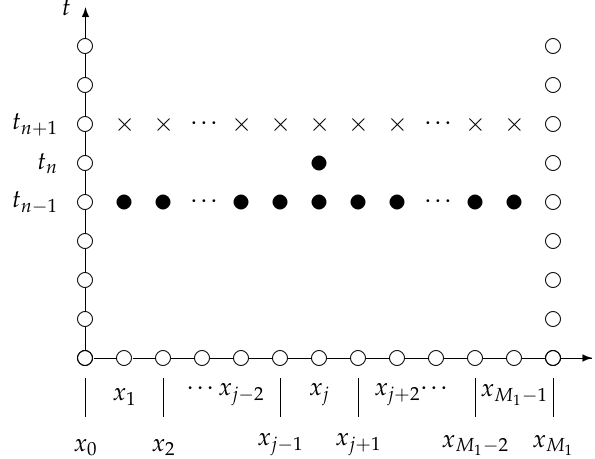
Figure 1. Stencil of the numerical model (36) at the time t n in one spatial dimension. The black circles denote the known solutions at the times t n − 1 and t n . Meanwhile, the crosses represent the unknown approximations at the time t n + 1 . For the sake of convenience, we agree that x j